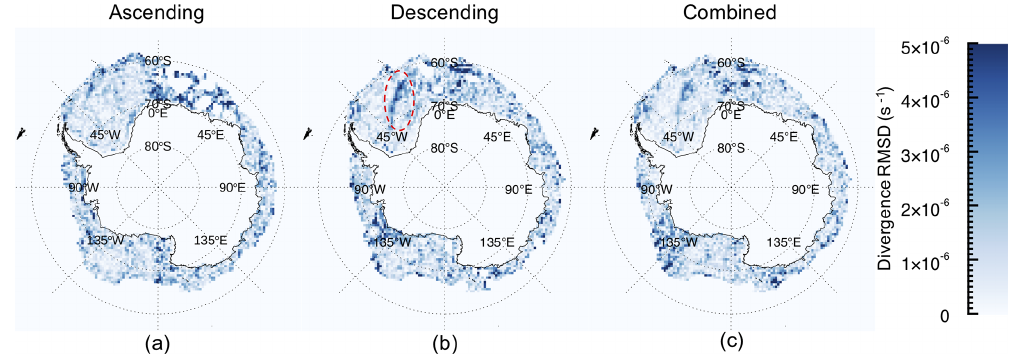
Figure 9. Mean D RMSD for (a) ASC, (b) DES, and (c) combined KIMURA new datasets of July 2017. The dashed red ellipse highlights the high D RMSD filamentary structure in the DES map, described in the